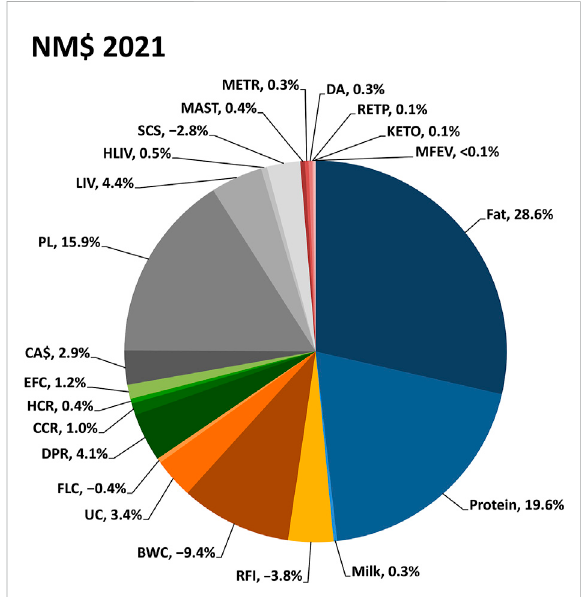
FIGURE 7 Relative emphasis on traits in the net merit (NM$) genetic- economic index revised in August 2021 by the Council on Dairy Cattle Breeding. Body weight composite, BWC; calving ability (calving ease and stillbirth rate), CA$; cow conception rate, CCR; cow livability, LIV; daughter pregnancy rate, DPR; displaced abomasum, DA; early fi rst calving, EFC; feet-legs composite, FLC; heifer conception rate, HCR; heifer livability, HLIV; ketosis, KETO; mastitis, MAST; metritis, METR; milk fever, MFEV; productive life, PL; residual feed intake, RFI; retained placenta, RETP; somatic cell score, SCS; udder composite,